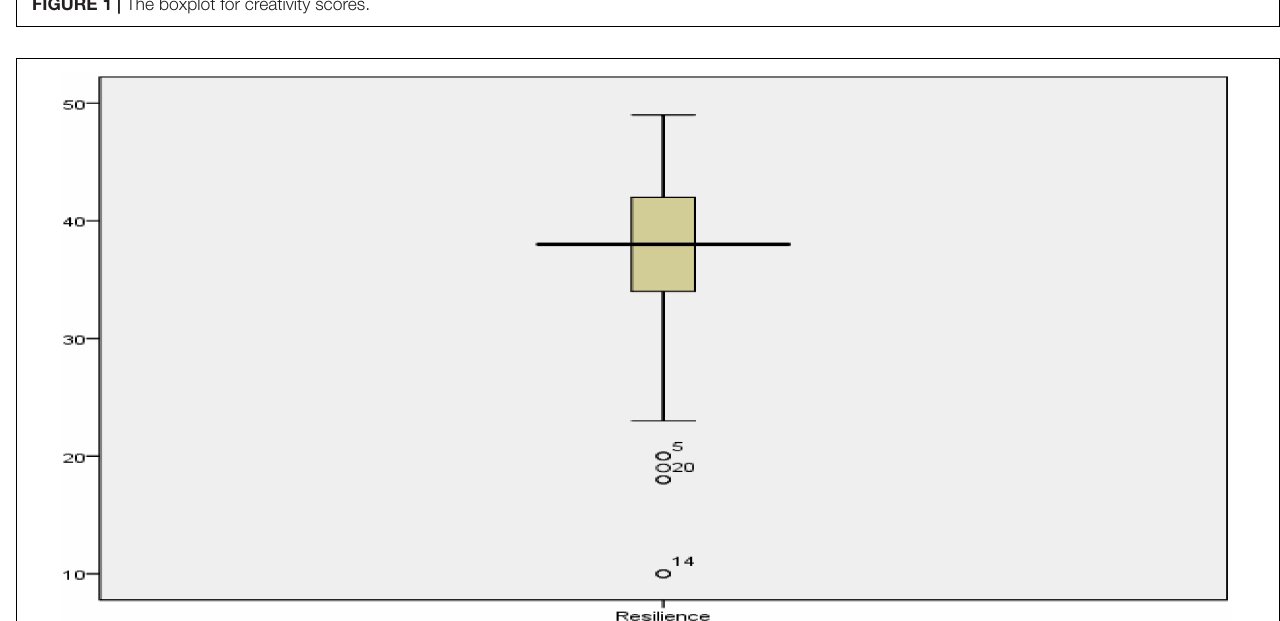
FIGURE 2 | The boxplot for resilience